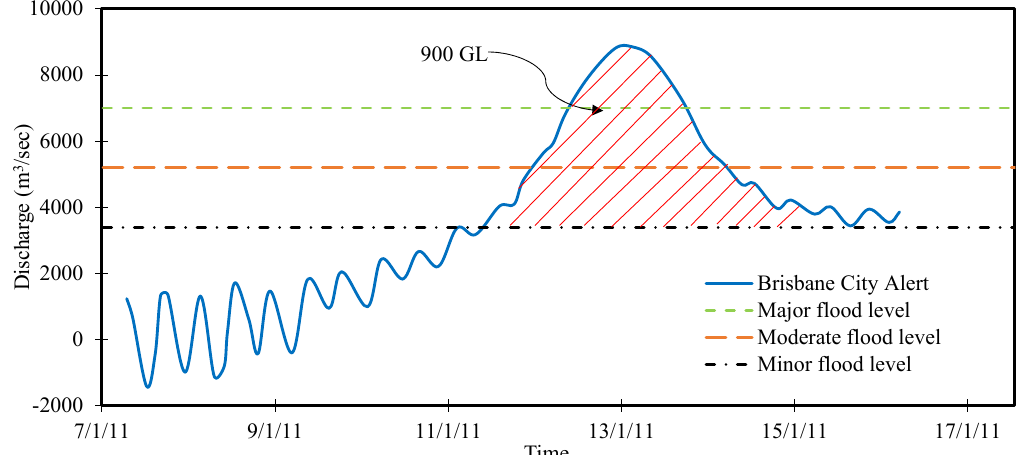
Figure 4. Brisbane City Alert 2011 flood hydrograph, with minor, moderate, and major flood levels Table 4. Comparison of proposed CR parameters with Qingcaosha CR.